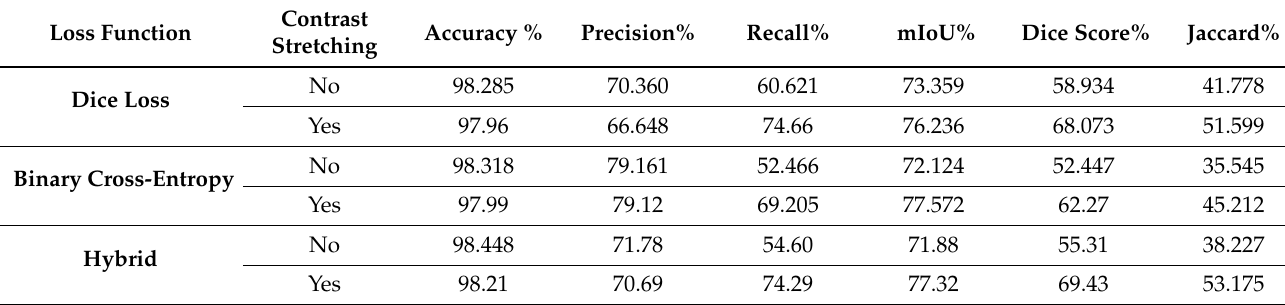
Table 3. ResU-Net++ performance metrics.